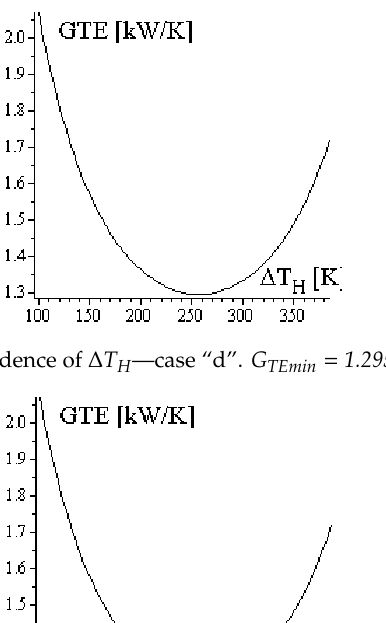
TRmin = 2.574 for Δ T R = 7.77 K.